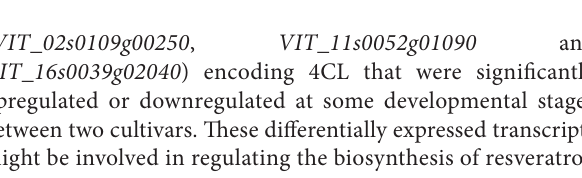
FIGURE 6 | The relationship between the module and the contents of trans -resveratrol and cis -resveratrol was performed by weighted gene co-expression network analysis